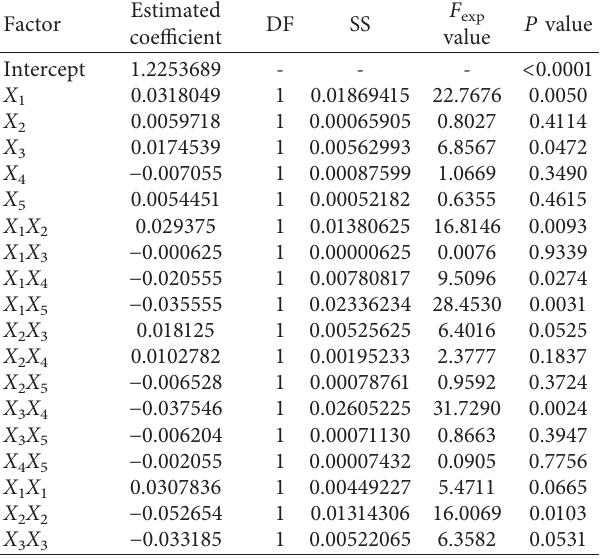
Table 5: Model coefficient estimated by multiple linear of % O response.